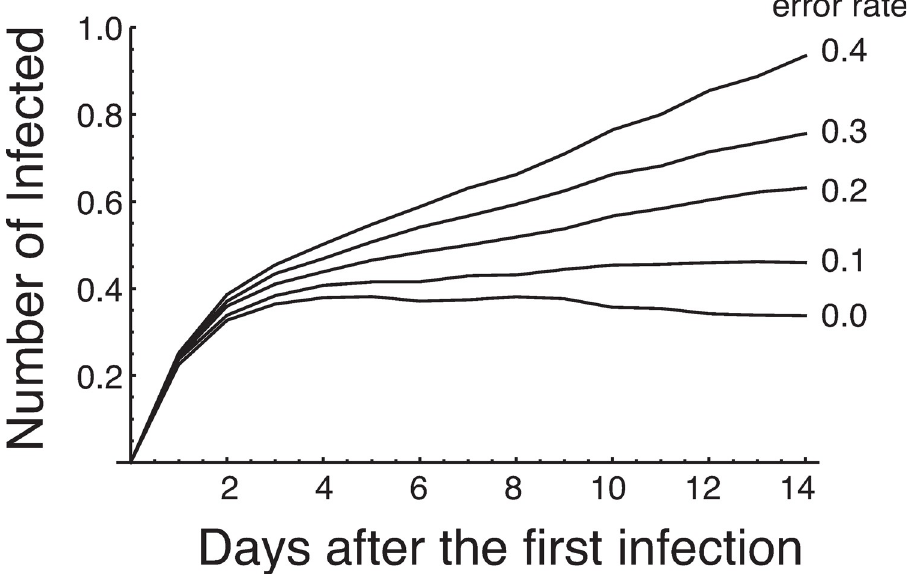
Fig 3. Infection dynamics in Group B with the test system including an additional PCR test for individuals who test positive for antigens. The initial condition of the dynamics is S (0) = 99, E (0) = 1, and all others are 0. The number of infected individuals in state E is excluded in the figure (see Eq 4 for the number of infected individuals). This is because individuals in state E are not infective and have no effect even if they participate in